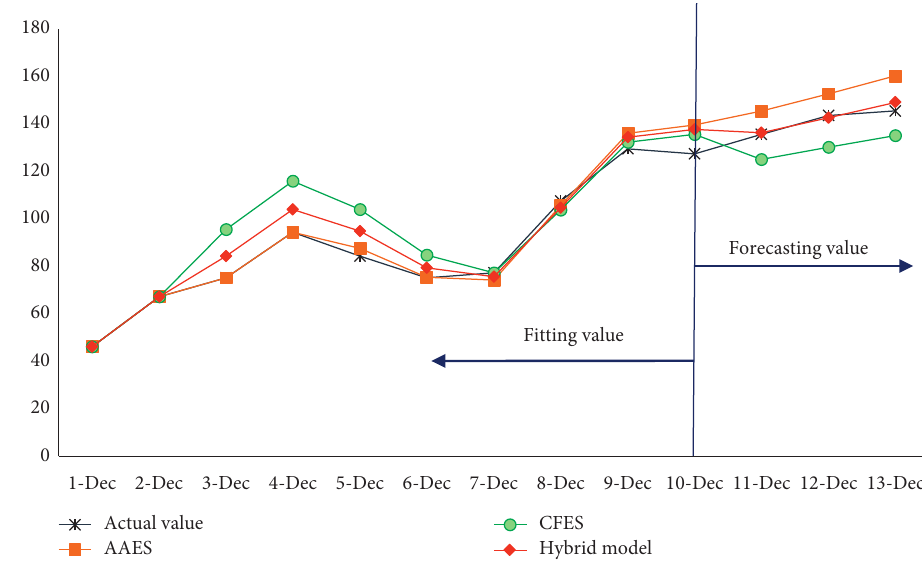
Figure 2: Prediction results of AQI concentration in four models.